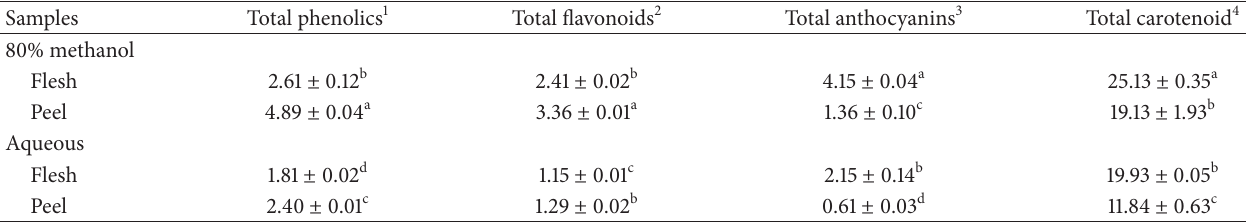
Table 1: Phytochemical contents of C. betacea fruit extracts.